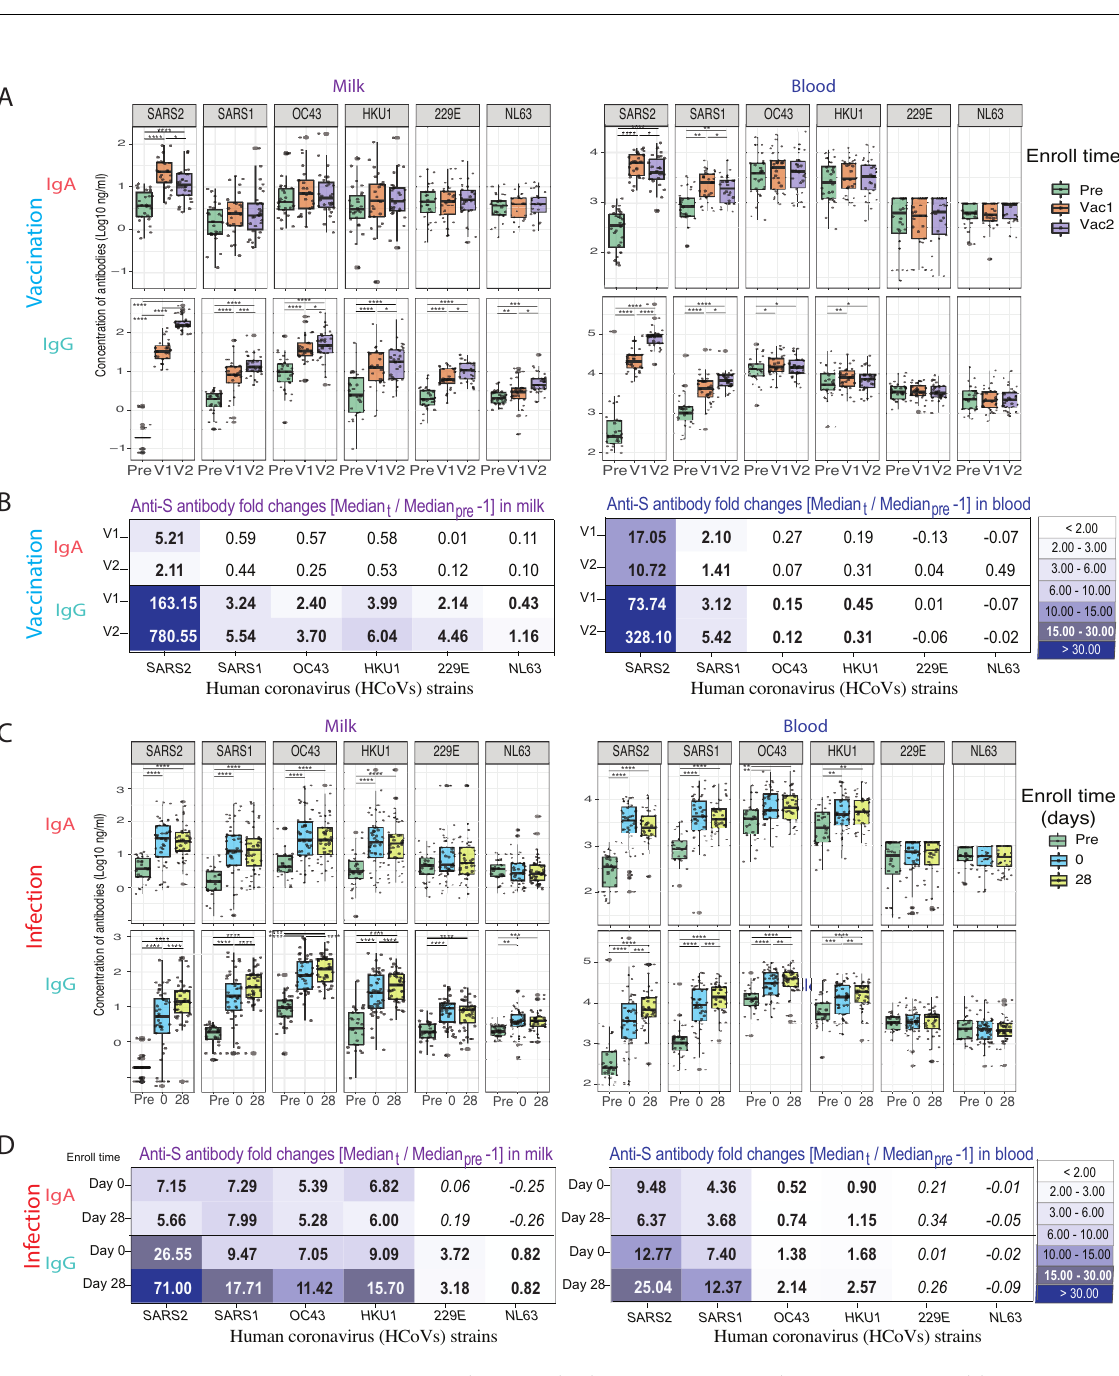
Figure 4. Anti-S IgA and IgG antibody response against human common cold coronaviruses (HCoVs) after SARS-CoV-2 vaccination and infection. The milk and blood HCoV-reactive IgA and IgG antibody levels against spike proteins of SARS-Cov-2 (SARS2), SARS-CoV-1 (SARS1), and HCoVs were mea- sured by multiplex assay. All samples were tested in one batch in duplicate, and significant increases of decreases over time were identified with generalized linear mixed-effects models (**** p < 0.0001, *** p < 0.001, ** p < 0.01, * p < 0.05) . ( A ) Milk and blood IgA and IgG antibodies against spike proteins of SARS2, SARS1, and HCoVs elicited by COVID-19 vaccination. ( B ) The antibody fold-changes of milk and blood anti-S IgA and IgG antibodies elicited by acute COVID-19 vaccination. (Fold change = [Median post-vac]/[Median pre-vaccination] − 1). Statistically significant changes are indi- cated in bold ( p < 0.05). ( C ) Milk and blood anti-S IgA and IgG antibodies elicited by acute COVID-19 infection. ( D ) The antibody fold-changes of milk and blood anti-S IgA and IgG antibodies elicited by acute COVID-19 vaccination. (Fold change = [Median post-infection]/[Median pre-vaccination] − 1). Statistically significant changes are indicated in bold ( p <